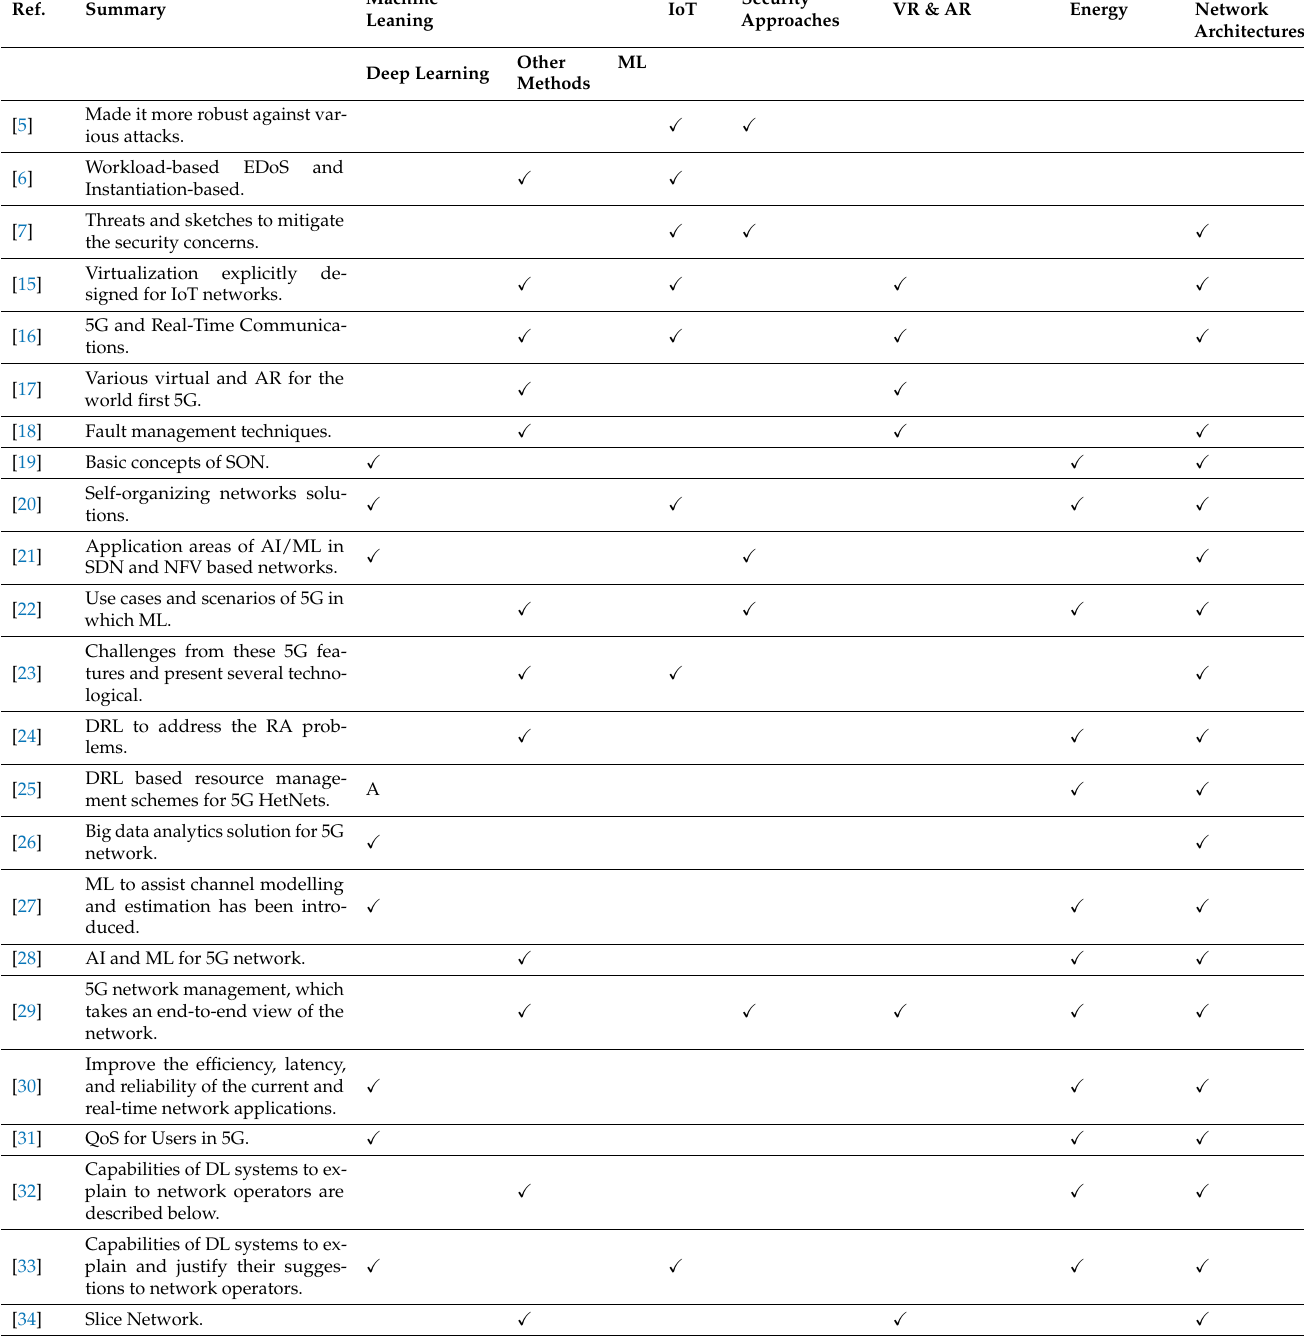
Table 1. Summary of the related review and survey